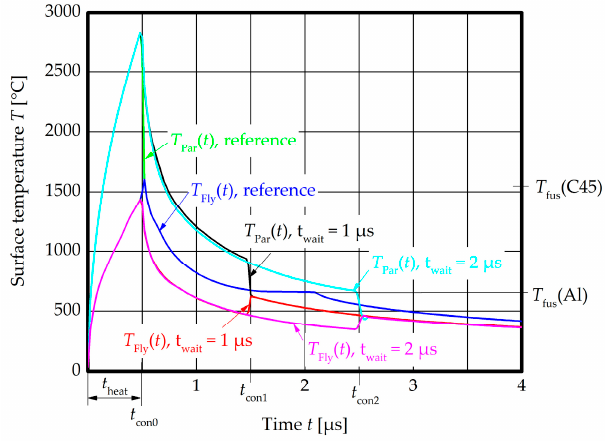
Figure 20. Comparison of T Fly ( t ) and T Par ( t ) for the reference setup and the setups with 1 µs and 2 µs waiting time.